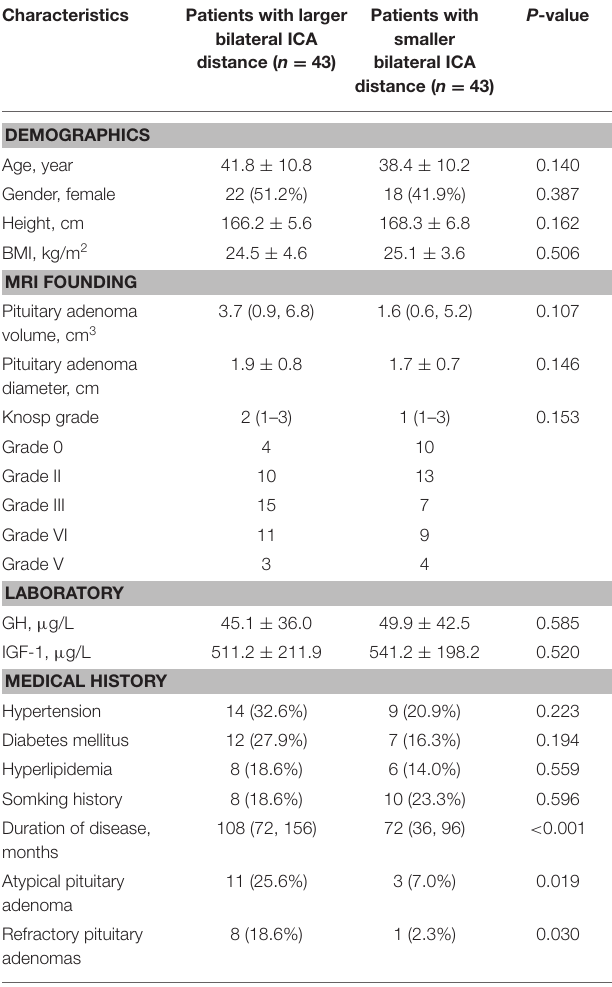
TABLE 2 | Comparison of demographic and clinical data in acromegalic patients according to bilateral ICAs distance.